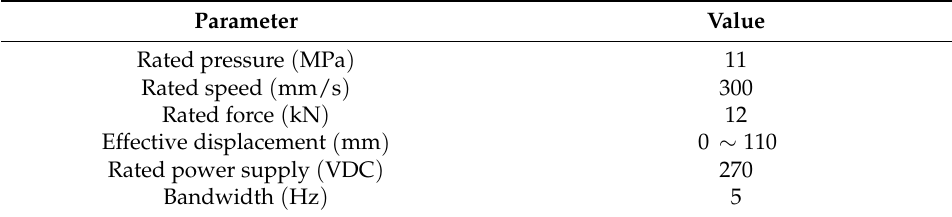
Figure 6. Schematic of test rig. Table 2. Specifications of EHA.